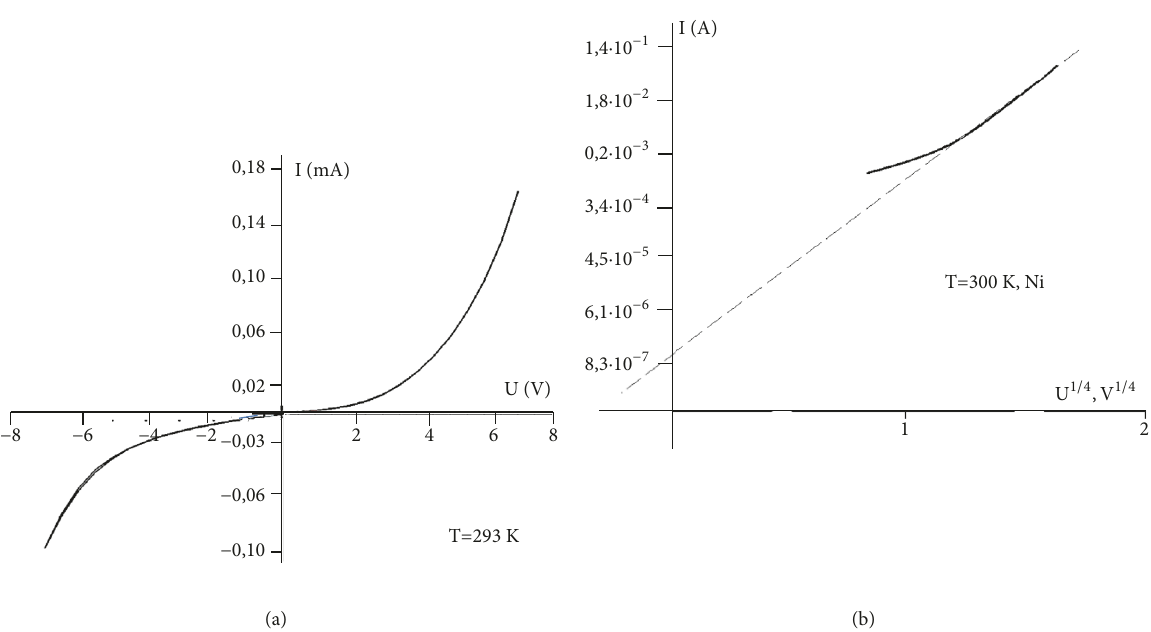
Figure 4: I–V characteristics curves of SiO 2 (Ni)/Si nanosystems at room temperature: I–V curve (a). Dependencies of ln 𝐼 on V 1/4 and the approximating curve for structures (b).